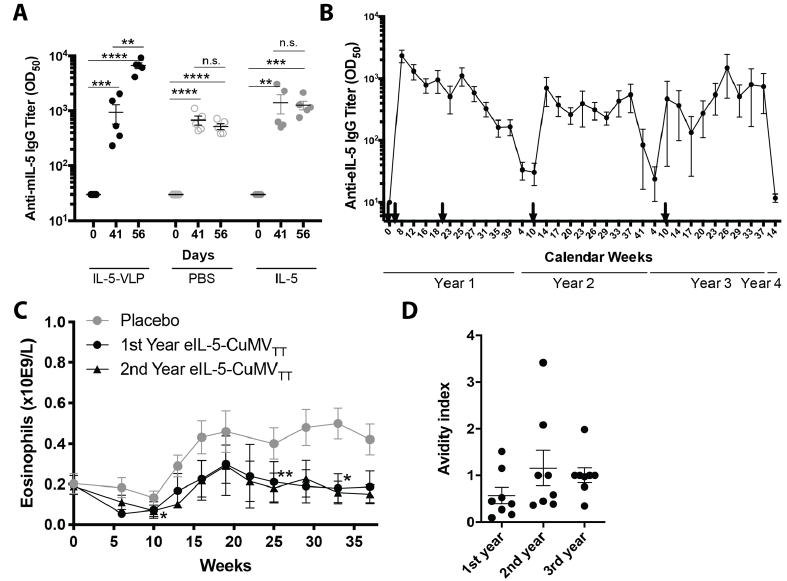
Figure 2. Longitudinal IL-5-specific IgG antibody titer including neutralization and avidity without self-induction. ( A ) Endogenous self-induction. IL-5-specific IgG antibody titers were measured in serum by the ELISA of mice following vaccination with mIL-5-VLP applied on days 0, 14, and 28 and an endogenous-mimicry challenge with either mIL-5-VLP (filled black), PBS (open), or mIL-5 alone (filled grey), applied on day 42. Individual antibody titers are per group ( n = 5) with mean and SEM. Significances were obtained by a 2-way ANOVA; multiple comparisons with paired t-tests are at different time points within groups. ( B ) Longitudinal anti-IL-5 IgG. Antibody titer reversibility shown by the course of IL-5-specific antibody titers in horses of a 3-year clinical study; IL-5-specific IgG antibody titers (mean +/ − SEM) were measured in the serum of horses over three years at different time points. Arrows indicate vaccine injections. The graph contains parts of data of Figure 1,2 of Fettelschoss-Gabriel et al. 2019, Allergy. ( C ) Course of eosinophils in the blood during three IBH seasons: placebo-treated season (grey circle, n = 13), first year (black circle, n = 13), and second year (black triangle, n = 11) vaccination season. Part of the data of Figure 2c is published in Fettelschoss-Gabriel et al. 2019, Allergy. The mean and SEM are shown, statistical analysis was performed by the Friedman test. (D) Avidity of the IL-5-specific IgG antibodies of eight horses after the yearly booster in the 1 st , 2 nd , and 3 rd year. The avidity index is plotted for individual horses in each year with the mean and SEM; the statistical analysis was performed by the Friedman test (*) followed by a multiple comparison test ( n.s .). ** p < 0.01; *** p < 0.001; **** p < 0.0001.